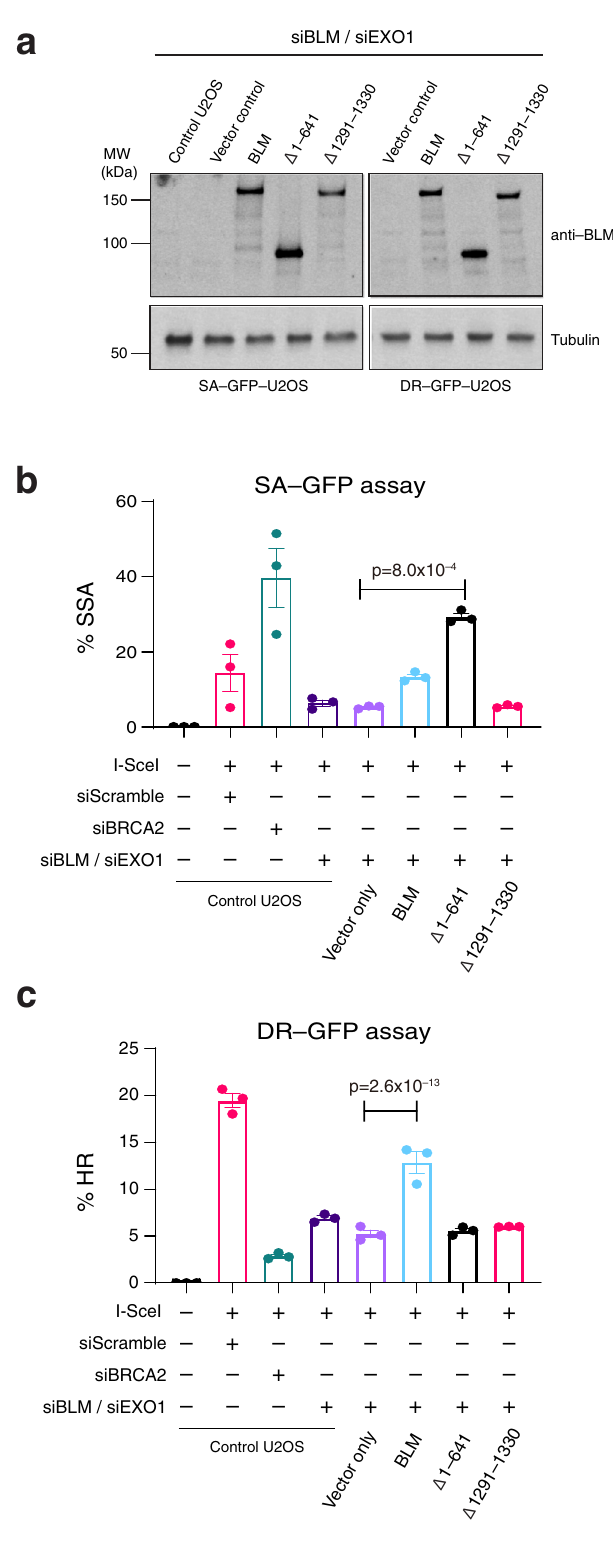
Fig. 8 Cell-based reporter assays for SSA and HR in cells expressing BLM Δ 1 – 641 or BLM Δ 1291 – 1330 . a Western blots of extracts from U2OS (SA- GFP and DR-GFP) cells depleted for BLM and EXO1 were reconstituted with the indicated genotypes and immune-stained with anti-BLM and anti- Tubulin antisera, as indicated. b Bar graph showing results for the SA-GFP reporter assay in U2OS cells with the indicated genotypes; data points represent %SSA. c Bar graph showing results for the DR-GFP reporter assay in U2OS cells with the indicated genotypes; data points represent %HR. In b and c data points re fl ect the mean ± SEM for N = three independent